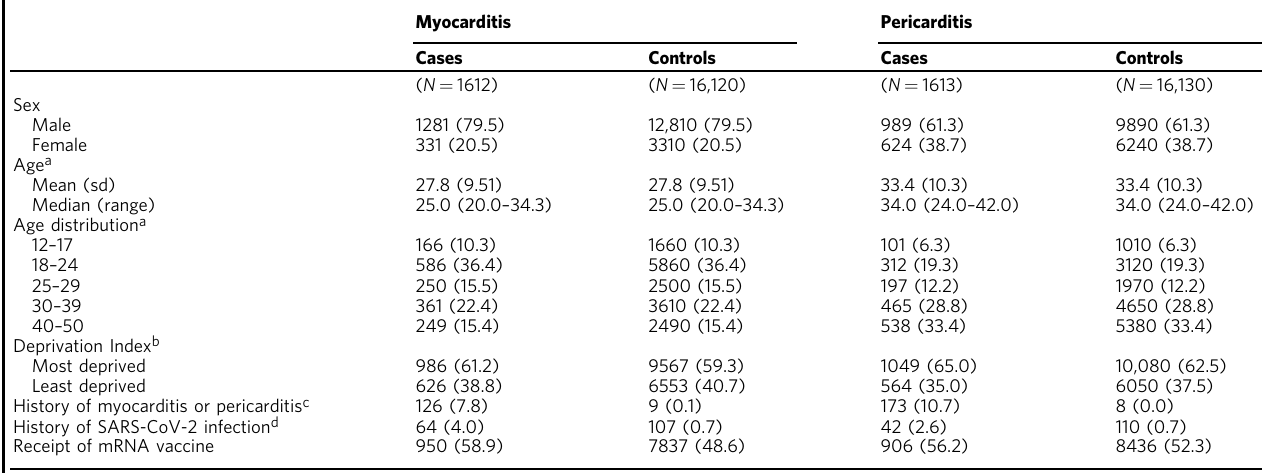
Table 1 Characteristics of study cases and controls.